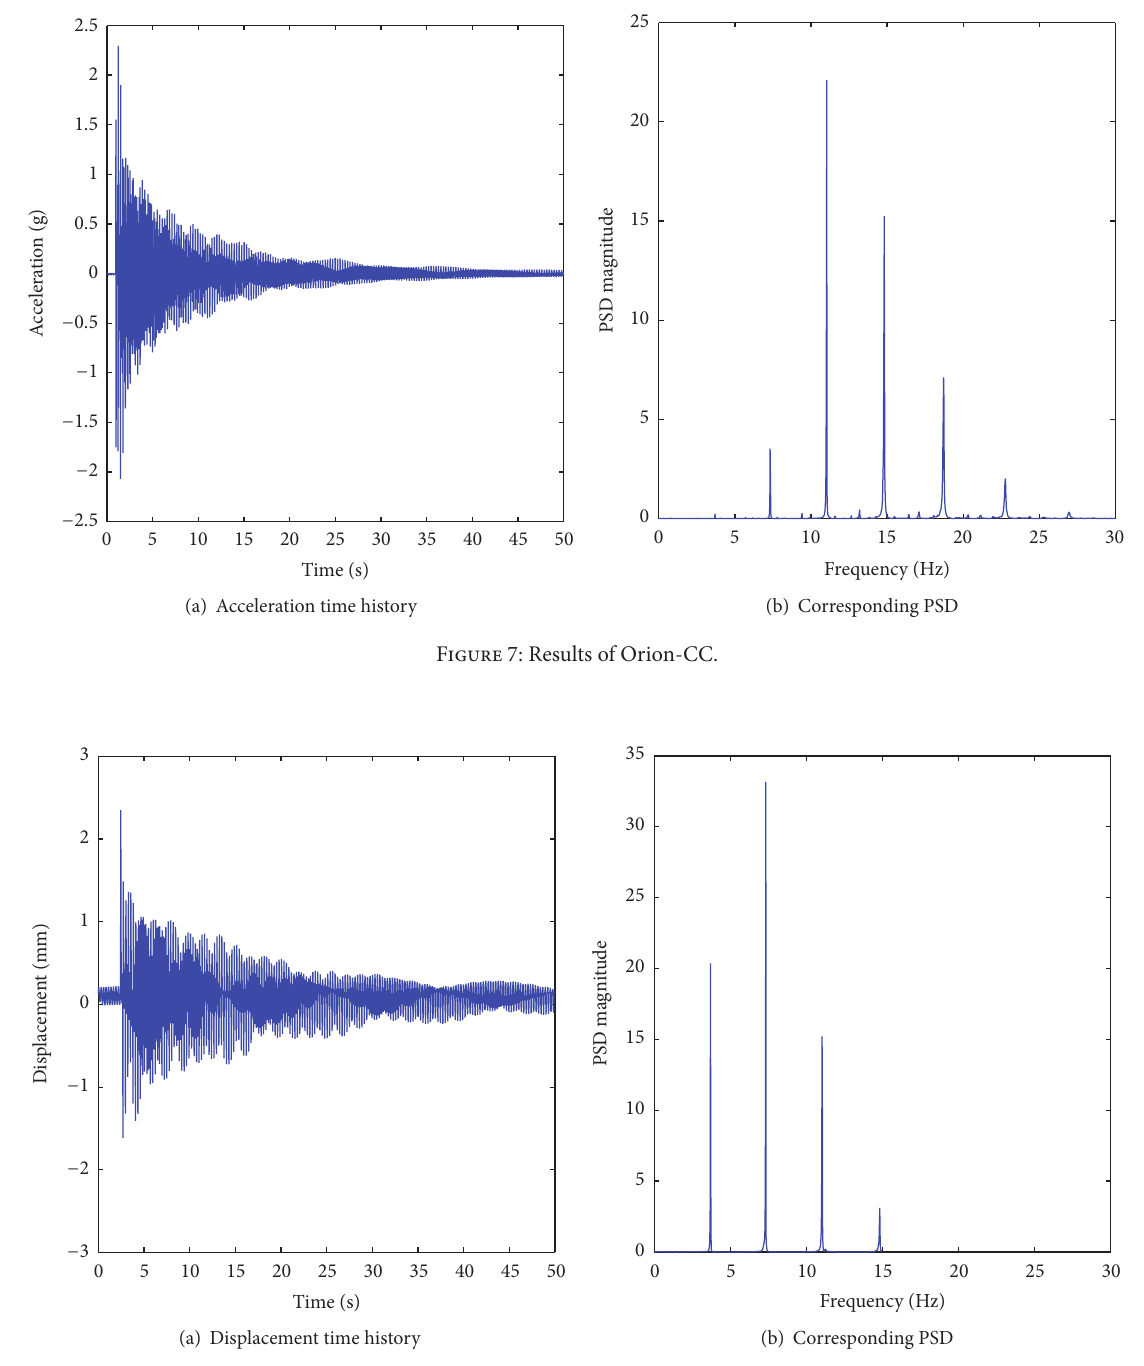
Figure 8: Results of